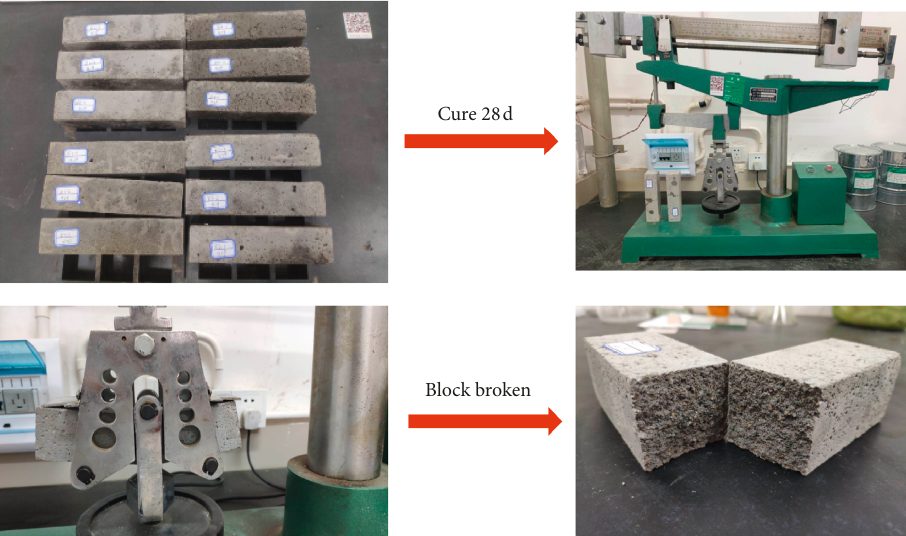
Figure 8: Flexural strength test of the solidified cement slurry.